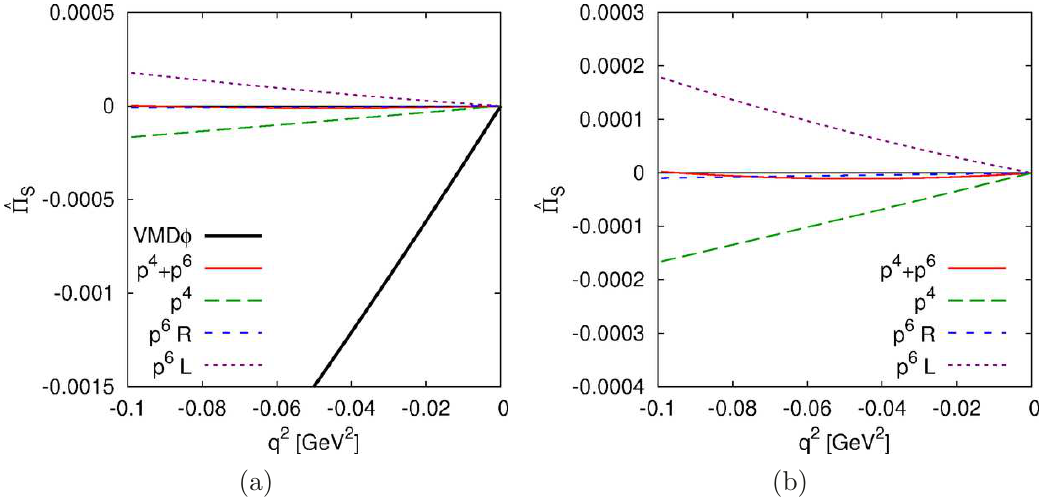
Figure 1 . (a) The different contributions to ˆΠ S ( q 2 ). The p 4 calculation, the pure two-loop part, p 6 R , the p 6 part depending on the p 4 LECs, p 6 L , and the pure LEC contribution as estimated in [29] using φ -dominance, V MDφ . (b) The different loop contributions only, i.e. the V MDφ contribution not included, with the same vertical scale as used in figure 2 but with a different range.